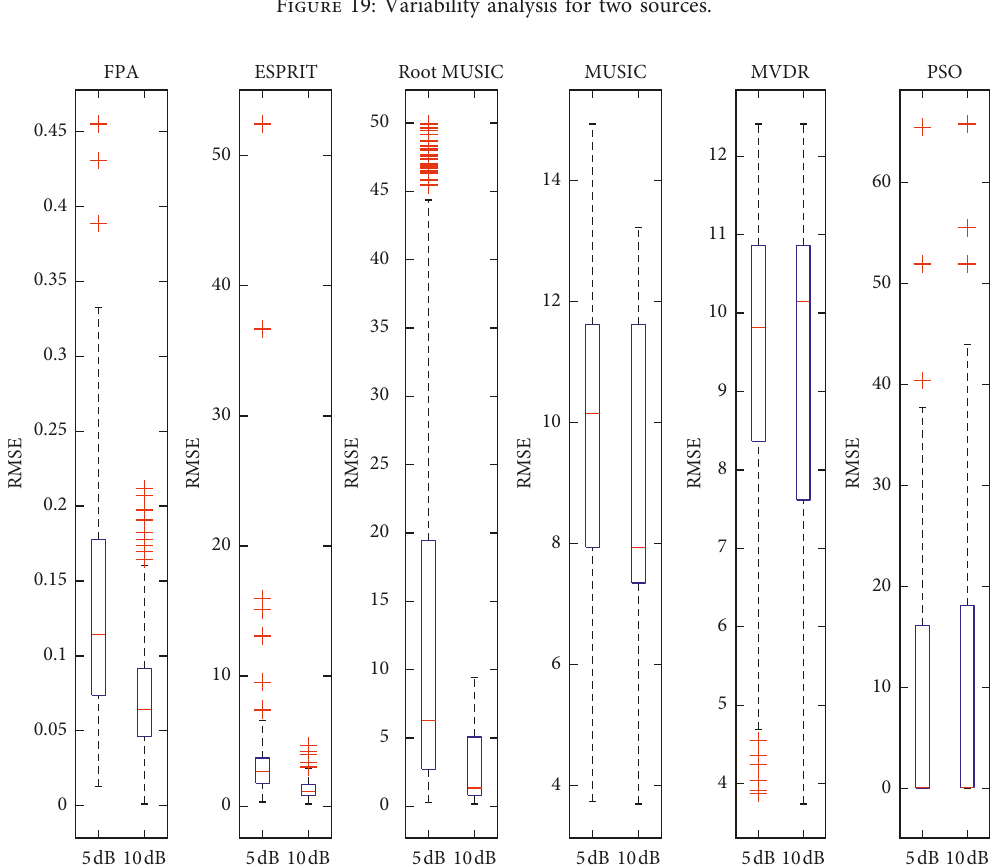
Figure 20: Variability analysis for three